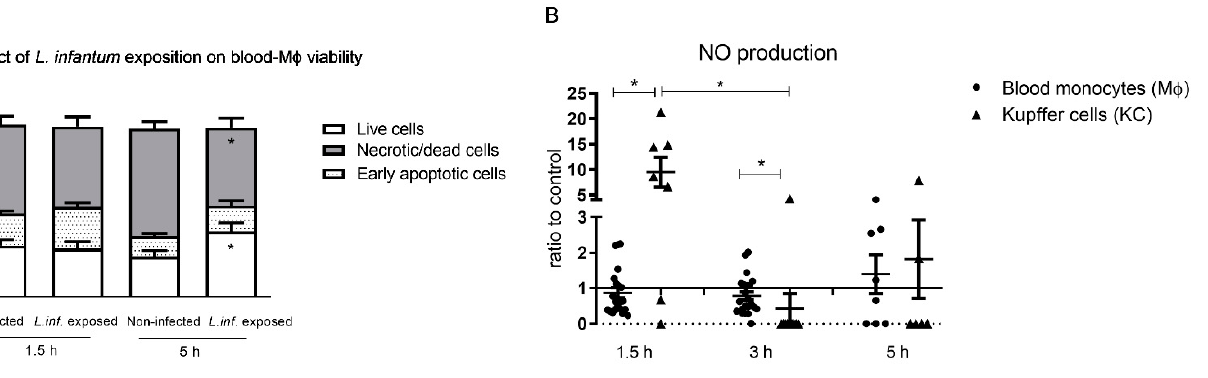
Figure 2. Internalization of L. infantum parasites by canine KCs. After 3 h ( A – D ) and 5 h ( E – H ) of exposure to L. infantum GFP amastigotes (white arrows), KCs were stained for CD68 (green), lysozyme (red) and nucleus (N) and fluorescent and visible light images were acquired. Co-localization of CD68 and lysozyme in lysosomal compartments (yellow) can be observed in overlapping images ( D , H ). CD68 and lysozyme accumulation can be noticed at 5 h of parasite exposure ( H ).